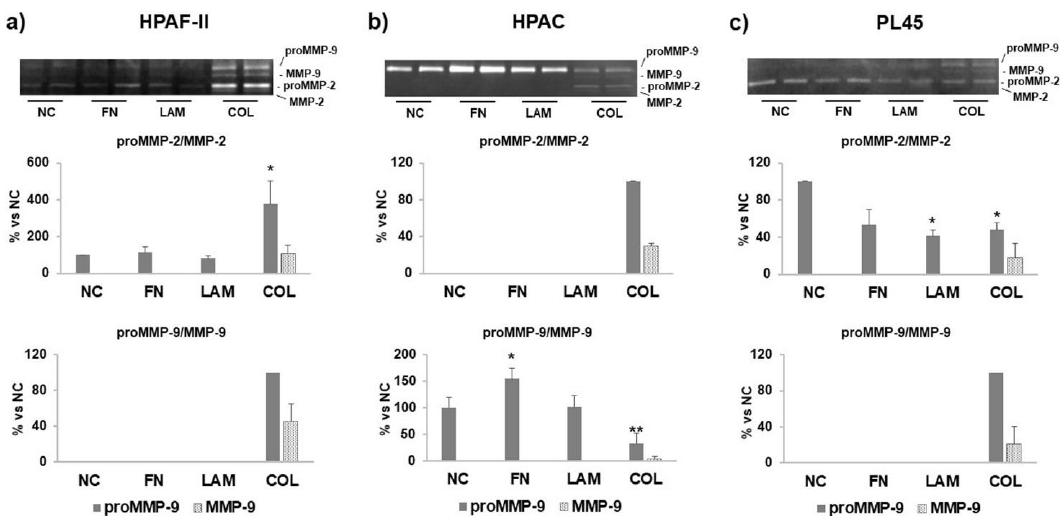
Figure 6. Matrix metalloprotenases-2 (MMP-2) and -9 (MMP-9) activity. Representative gelatin zymograms and bar graphs showing MMP-2 and MMP-9 activity in supernatants from ( a ) HPAF-II, ( b ) HPAC, and ( c ) PL45 cells cultured on FN, LAM, COL, or without coating (NC). Matrix